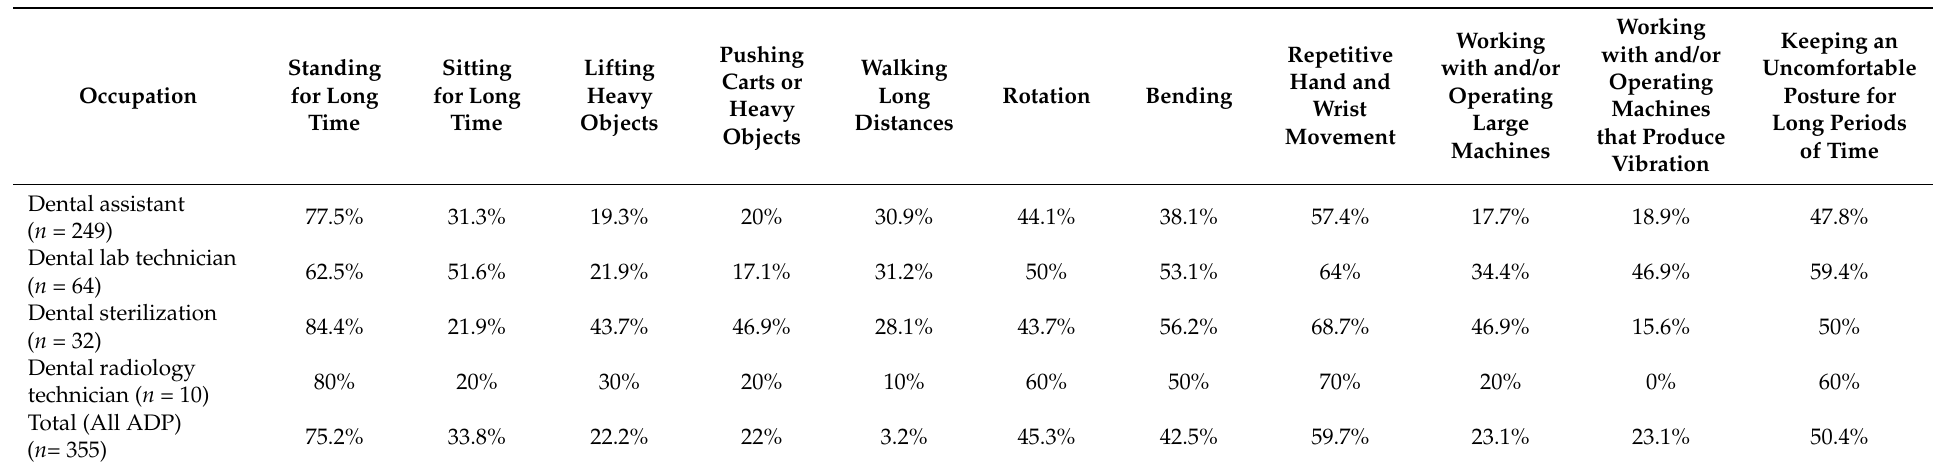
Table 3. Reported typical physical movement performed for ADP occupations ( n = 355).